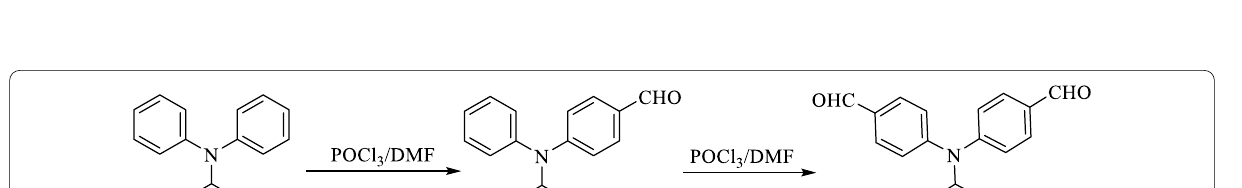
Fig. 1 Molecular structures of the new sensitizers SM1-5 and N-719